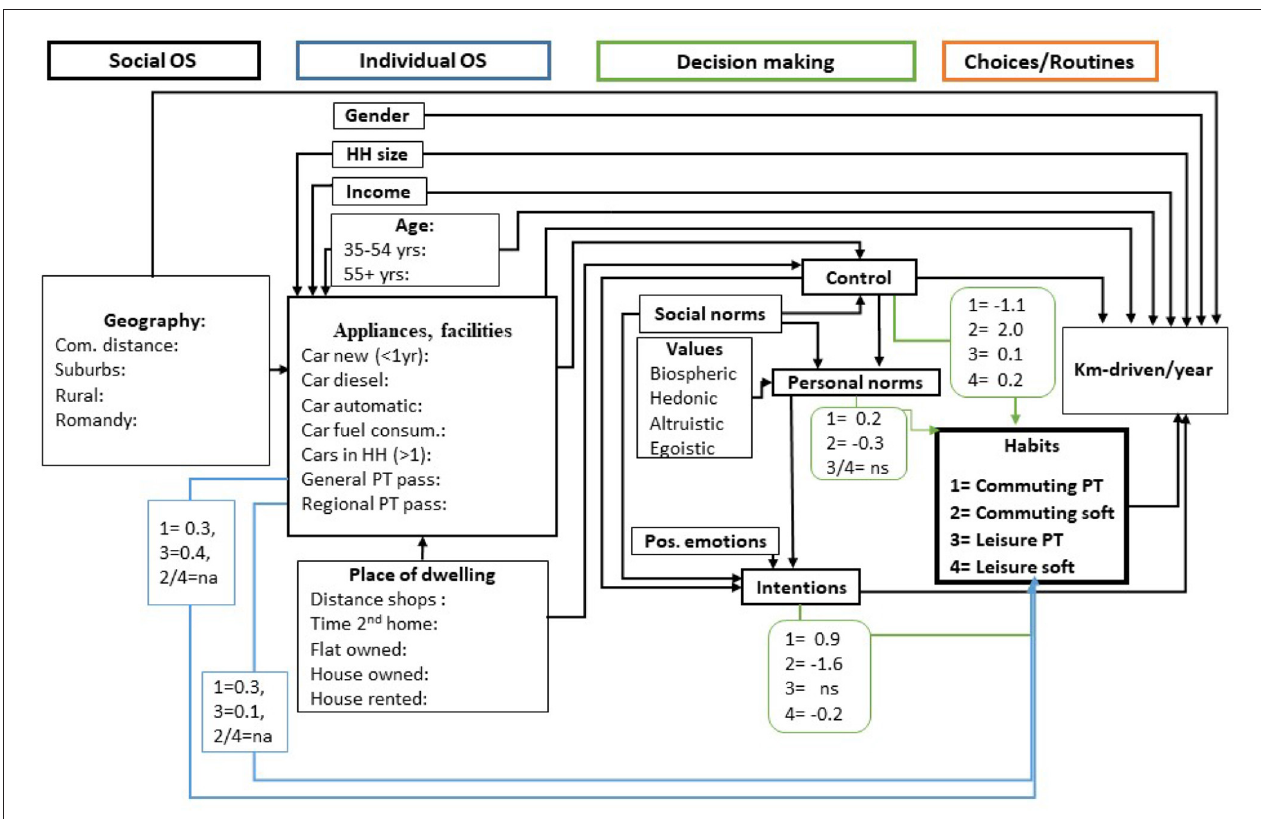
FIGURE 5 | Indirect pathways explaining km-driven/year via habits for commuting and leisure by public transport (PT) and soft mobility (e.g., bike, walking). Reported are standardized direct coefficients with p < 5% (complete results are provided in Tables A5, A6 ). Numbers 1–4 refer to the different types of habitual behavior: 1: habitual use of public transport (PT) for commuting, 2: habitual use of soft transport measures for commuting, 3: habitual use of PT for leisure purposes, 4: habitual use of soft mobility measures for leisure purposes. na = not applicable, meaning this path was not tested; ns = not significant at